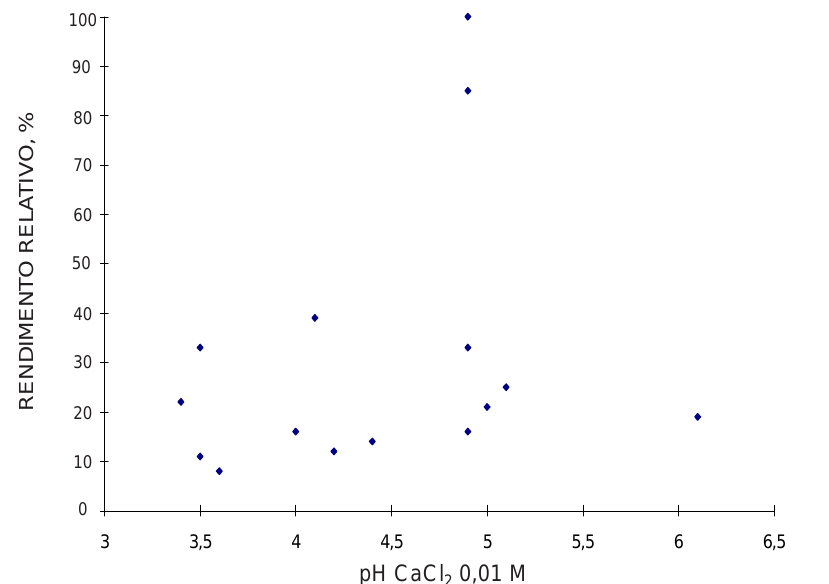
Figura 1. Rendimento relativo (%) de matéria seca de plantas de milho em função do pH em CaCl das amostras de